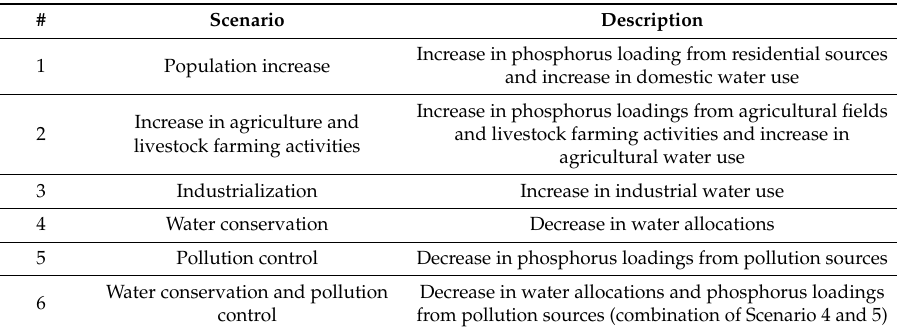
Table 3. System Dynamics (SD) model scenarios.